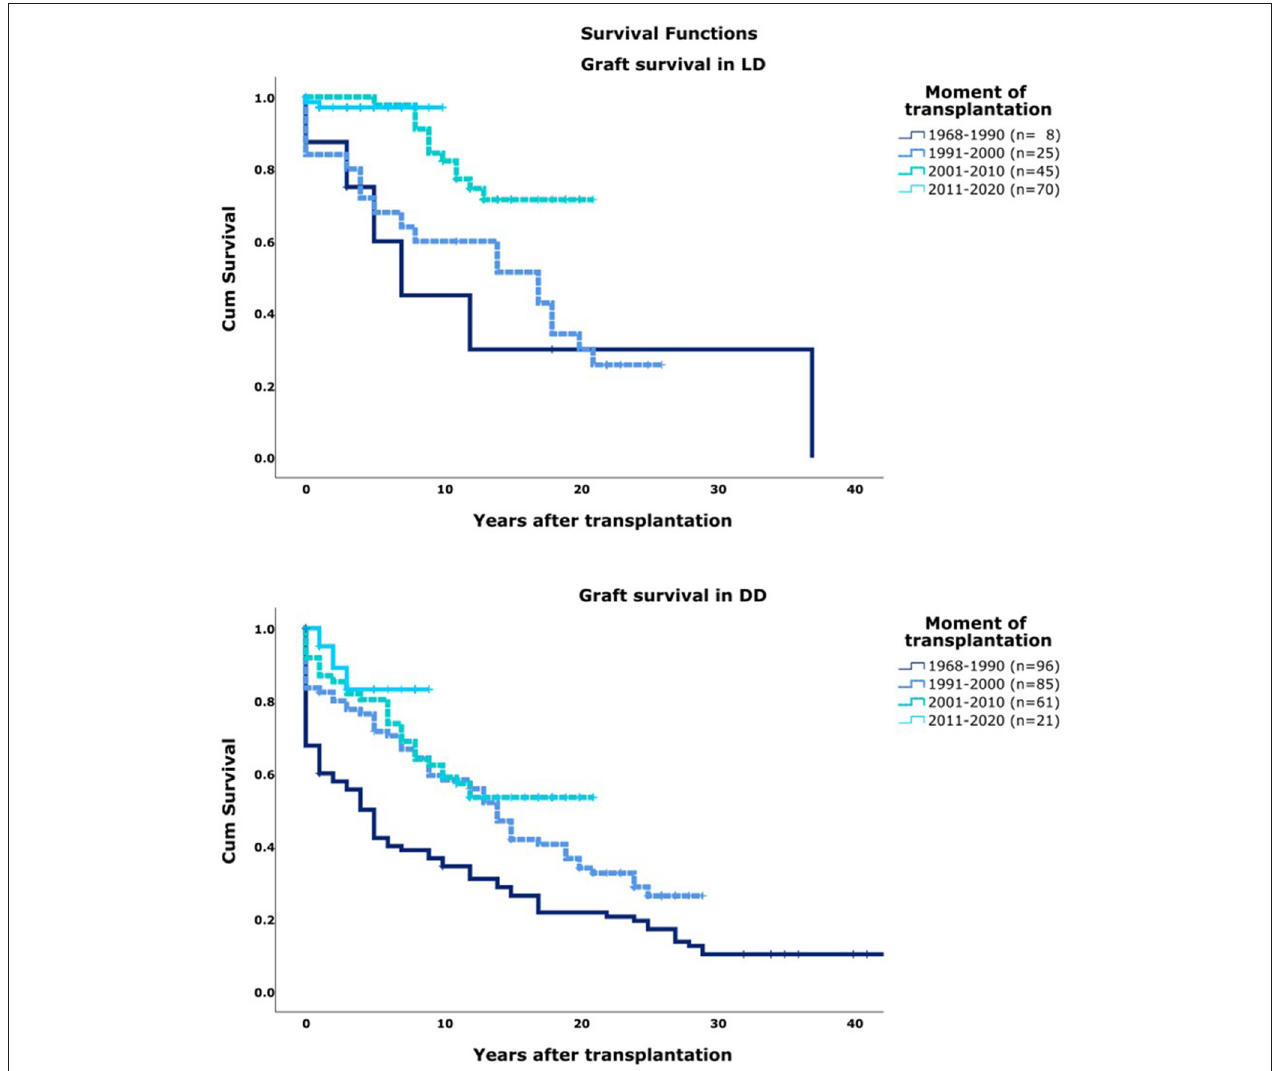
FIGURE 1 | Graft survival per decade of transplantation. T0, moment of transplantation. DD, deceased donor; LD, Living